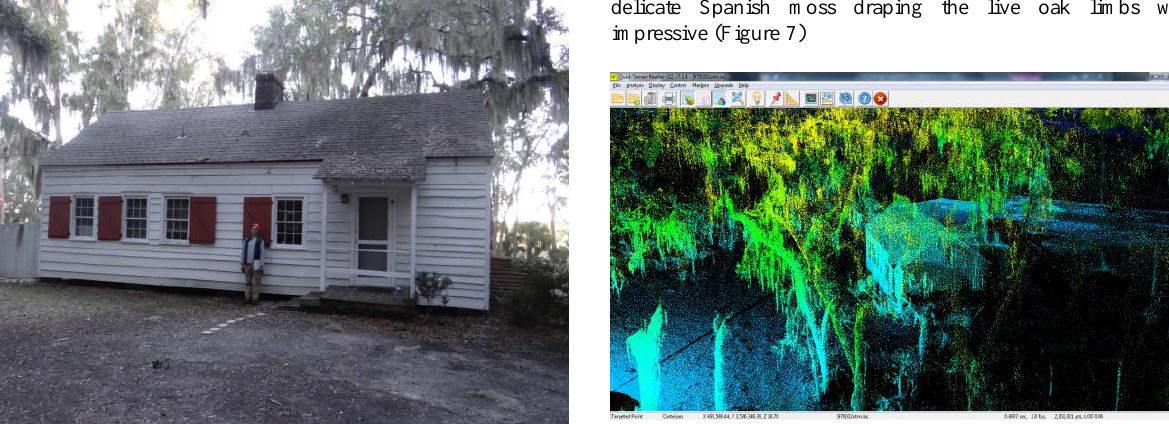
Figure 7. Terrestrial laser scan of the slave cabin. Note the Figure 5. The original slave cabin at Wormsloe is now used for Spanish moss hanging from the limbs of the live oak research housing.